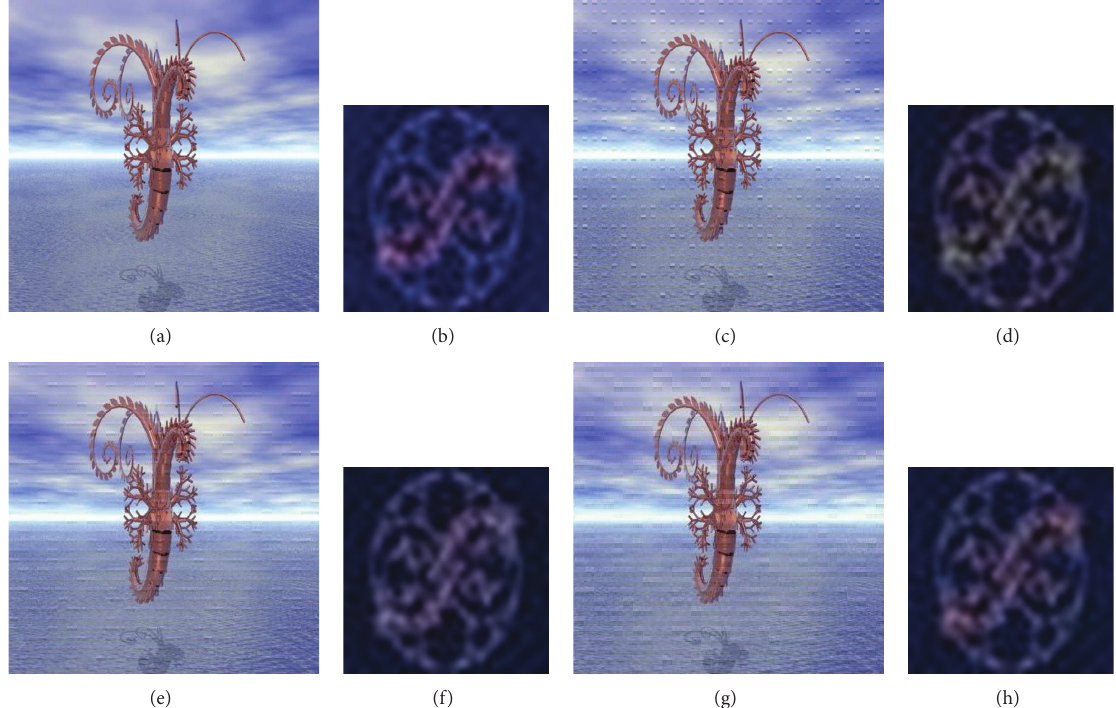
Figure 13: Comparison between the classical non-blind Video Multiple Watermarking System (Video Watermark) and the Proposed Method: where (a) and (b) Original Video Frame and Original Watermark, (c) and (d) Watermarked Video Frame and Recovered Watermark without Interlacing, (e) and (f) Watermarked Video Frame and Recovered Watermark with One Level Interlacing, (g) and (h) Watermarked Video Frame and Recovered Watermark with Two Level